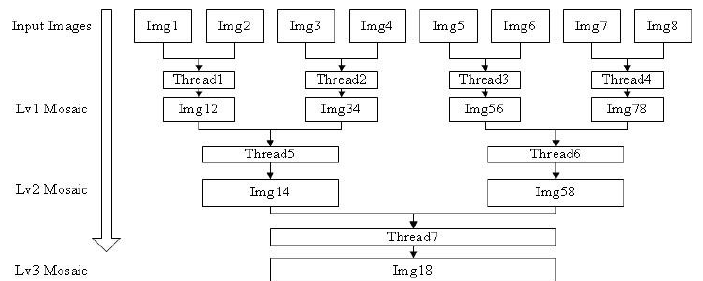
Figure 1. Principle of multi-level and